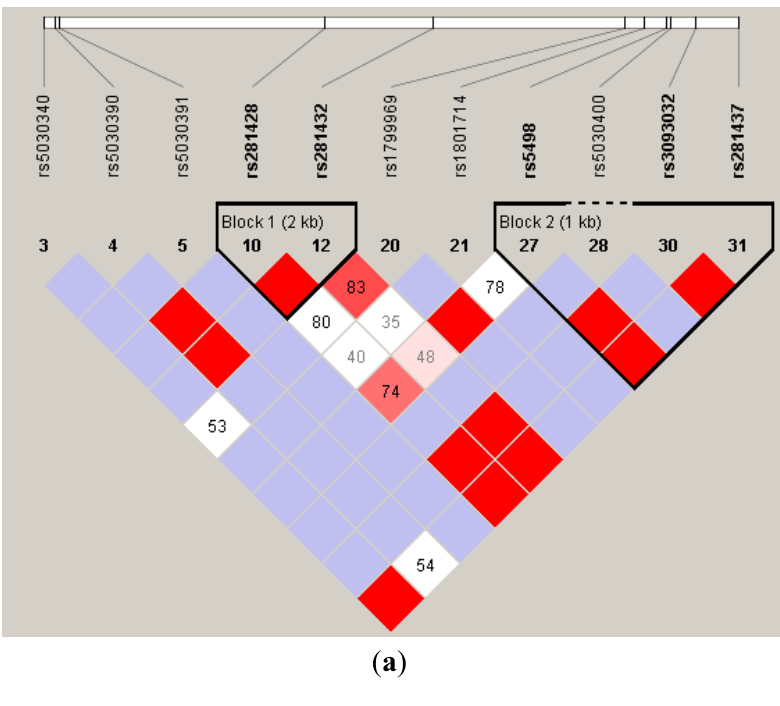
Figure 2. The likage equalibrium of ICAM1 single-neuclitide polymorphsms (SNPs) by different race populations: ( a ) CEU (Utah residents with Northern and Western European ancestry), ( b ) CHB (Han Chinese in Beijing, China), and ( c ) YRI (Yoruban in Ibadan, Nigeria). The minor allele frequency (MAF) of the two studied SNPs (rs5491 and rw5498) are shown. Data was dowloaded from HapMap (Data Rel 27 PhaseII + III on NCBI B36 assembly, dbSNP